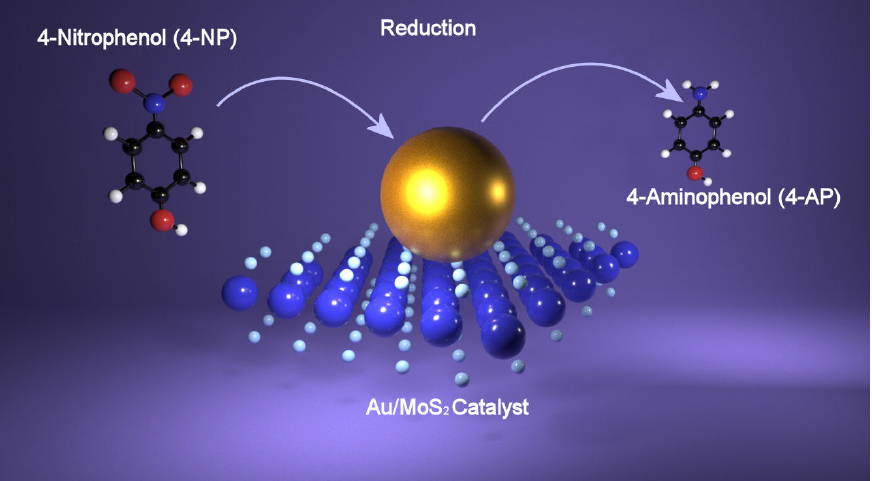
Figure 4. Reduction of 4-nitrophenol (4-NP) catalyzed by Au-MoS 2 nanohybrid by which 4-aminophenol (4-AP) is obtained.